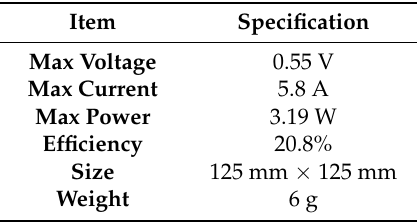
Table 3. Specifications of the PV cell.